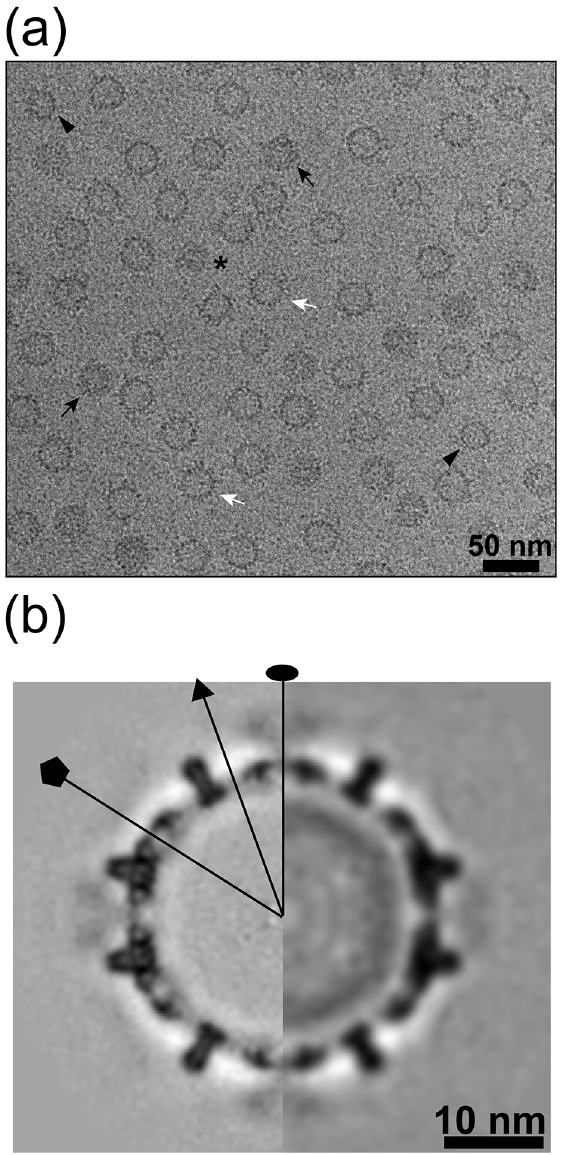
Fig 8. Cryo-EM reconstruction of Cp183-Imp β complex in sodium chloride. (a) Representative cryo-EM micrograph of Cp183 capsid (11 μ M dimer) and 18.8 μ M Imp β , a ratio of 205 importins per capsid, in 0.15 M NaCl. Most particles appear to be empty (white arrow), but some dark particles (black arrow), T = 3 particles (black arrowhead), and defective particles (star) were observed. (b) The central sections of the 3D reconstructions, computed from all particles (left) and the dark particles (right), show an internal dark ring of density. Oval, triangle, and pentagon indicate locations of twofold, threefold and fivefold axes, respectively. The reconstructions were determined to 8.9 Å resolution for all particles and 15.9 Å resolution for the dark particles.